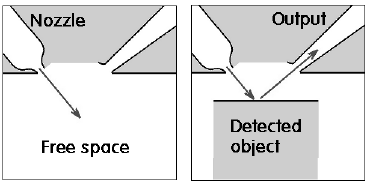
Fig. 2. Essentially the same the same wrong idea of jet behaviour proposed to the author on a different occasion. The “reflected” jet was in this case expected to generate an output signal about the presence of the object.